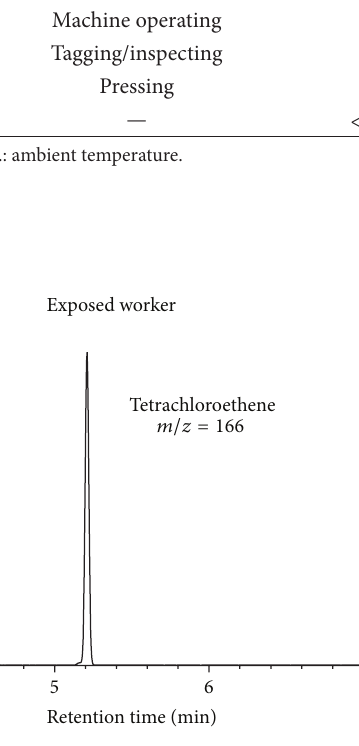
Figure 9: Representative chromatogram of an end-exhaled air sample from a dry-cleaning worker (machine operator) exposed to tetrachloroethene; tetrachloroethene peak (retention time 5.2 min, m/z 166).